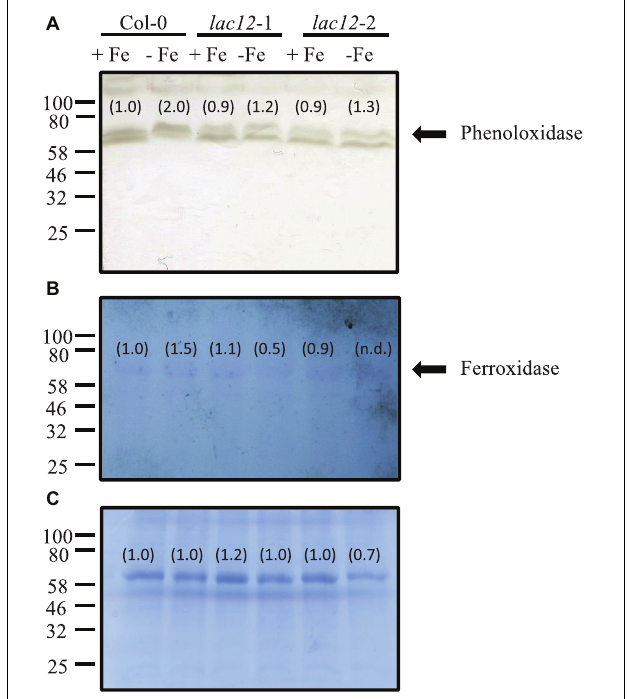
FIGURE 6 | In-gel phenoloxidase and ferroxidase activities in lac12 mutants. In-gel detection of phenoloxidase (A) and ferroxidase (B) activities in total protein extracts from roots of WT, lac12 -1 and lac12 -2 seedlings grown on vertically oriented petri plates as described in Figure 3 . Thirty micrograms of protein were loaded per lane. Data shown are from one single independent experiment. (C) Coomassie blue staining to visualize protein